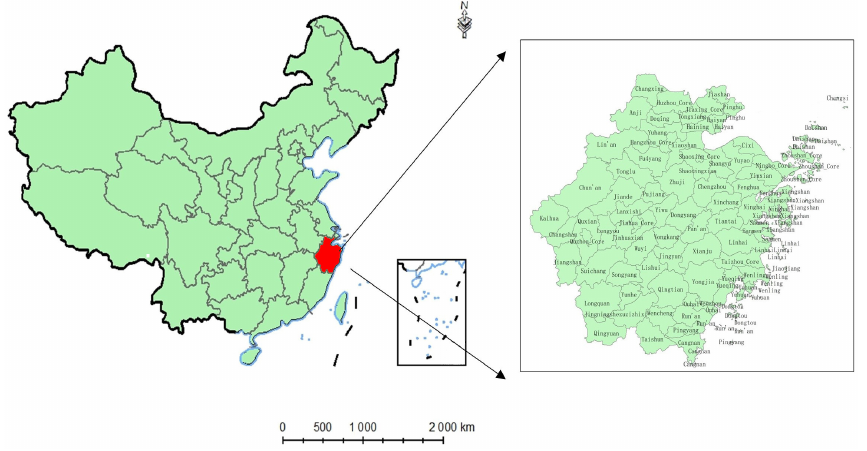
Figure 2. Geographical location and administrative division map of Zhejiang Province.